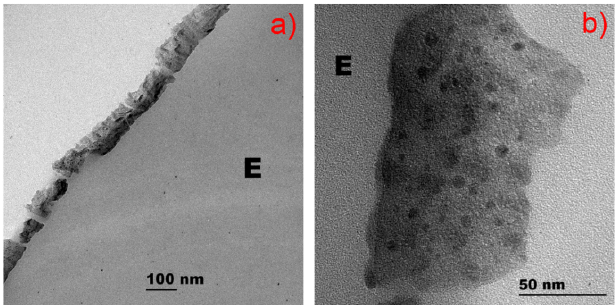
Figure 9. Transmission electron microscopy (TEM) of: ( a ) Cu sputtered for 150 s by HIPIMS on polyester; ( b ) Cu ‐ TiO 2 sputtered for 150 s by HIPIMS on polyester.